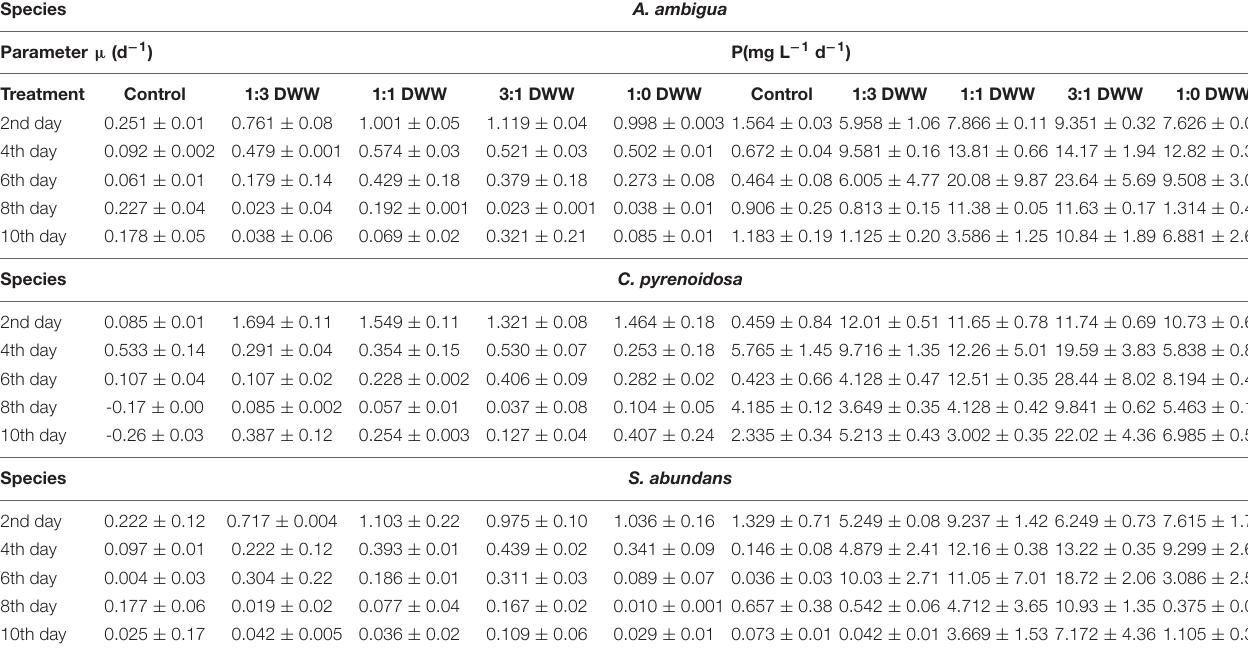
TABLE 2 | Growth profile of A. ambigua , C. pyrenoidosa, and S. abundans in dairy wastewater in terms of specific growth rate and biomass productivity. Species